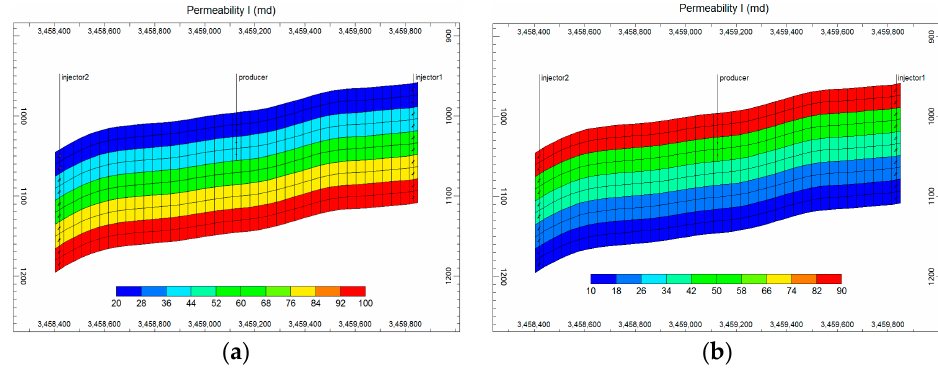
Figure 6. Permeability distribution of numerical model. ( a ) Positive rhythm; ( b ) Reverse rhythm. Table 8. Basic information of each layer in two-dimensional numerical model. The numerical well group model was cut from the actual gas reservoir model. The central depth of the model was 1750 m; the formation temperature was 66.8 ◦ C; the initial pressure was 18 MPa; and the water saturation was 45%. The model was established by corner-point grids which amounted to 9000 (30 × 30 × 10), and the areal grid dimension was 50 m × 50 m. Five-point vertical well pattern was adopted, and the well types (production or injection well) were set according to the development phase. The grid setting and well location of the three-dimensional model are shown in Figure 7a.